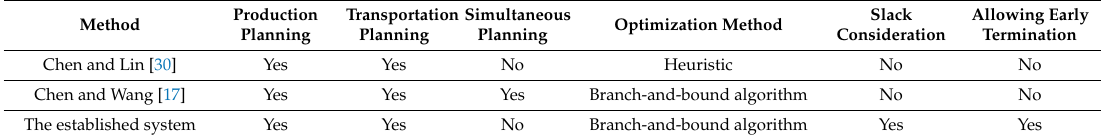
Table2. Thedi ff